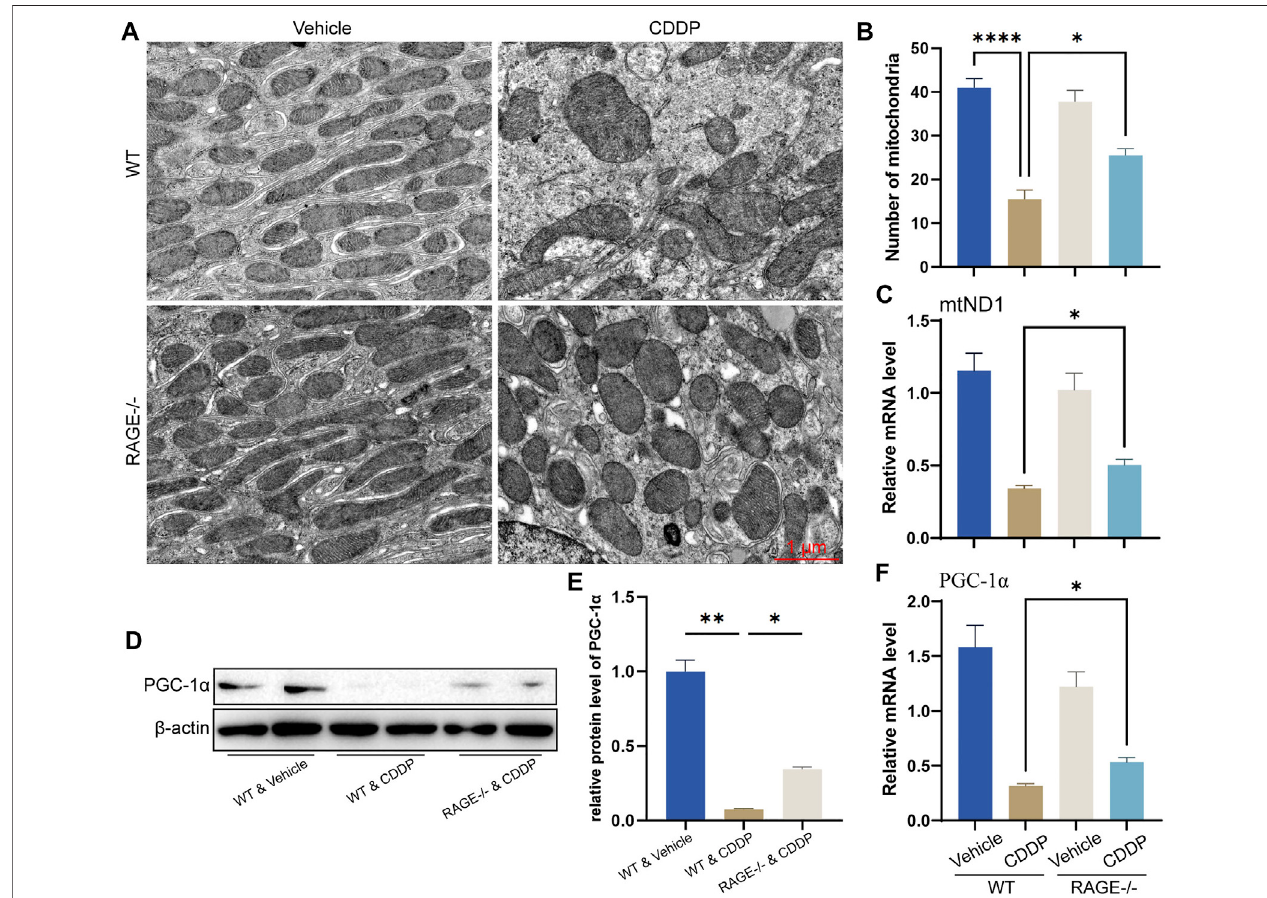
FIGURE 4 | RAGE knockout restored cisplatin-induced mitochondrial homeostasis. (A) Mitochondrial morphology of mouse renal tubular epithelial cells was observed using transmissionelectron microscopy(TEM). (B) The number ofmitochondria wascounted according toTEM. (C) The mRNA level ofmtND1, indicating the relative copy number of cellular mitochondria. (D) The protein level of PGC-1 α was detected by western blot and then semi-quanti fi ed in a histogram (E) . (F) The mRNA levelofPGC-1 α determinedbyqPCR.One-wayANOVAwasusedtocomparemeansbetweengroups.Dataareexpressed asmean±SEM.Scalebar:1 μ m.* p < 0.05, ** p < 01, **** p <